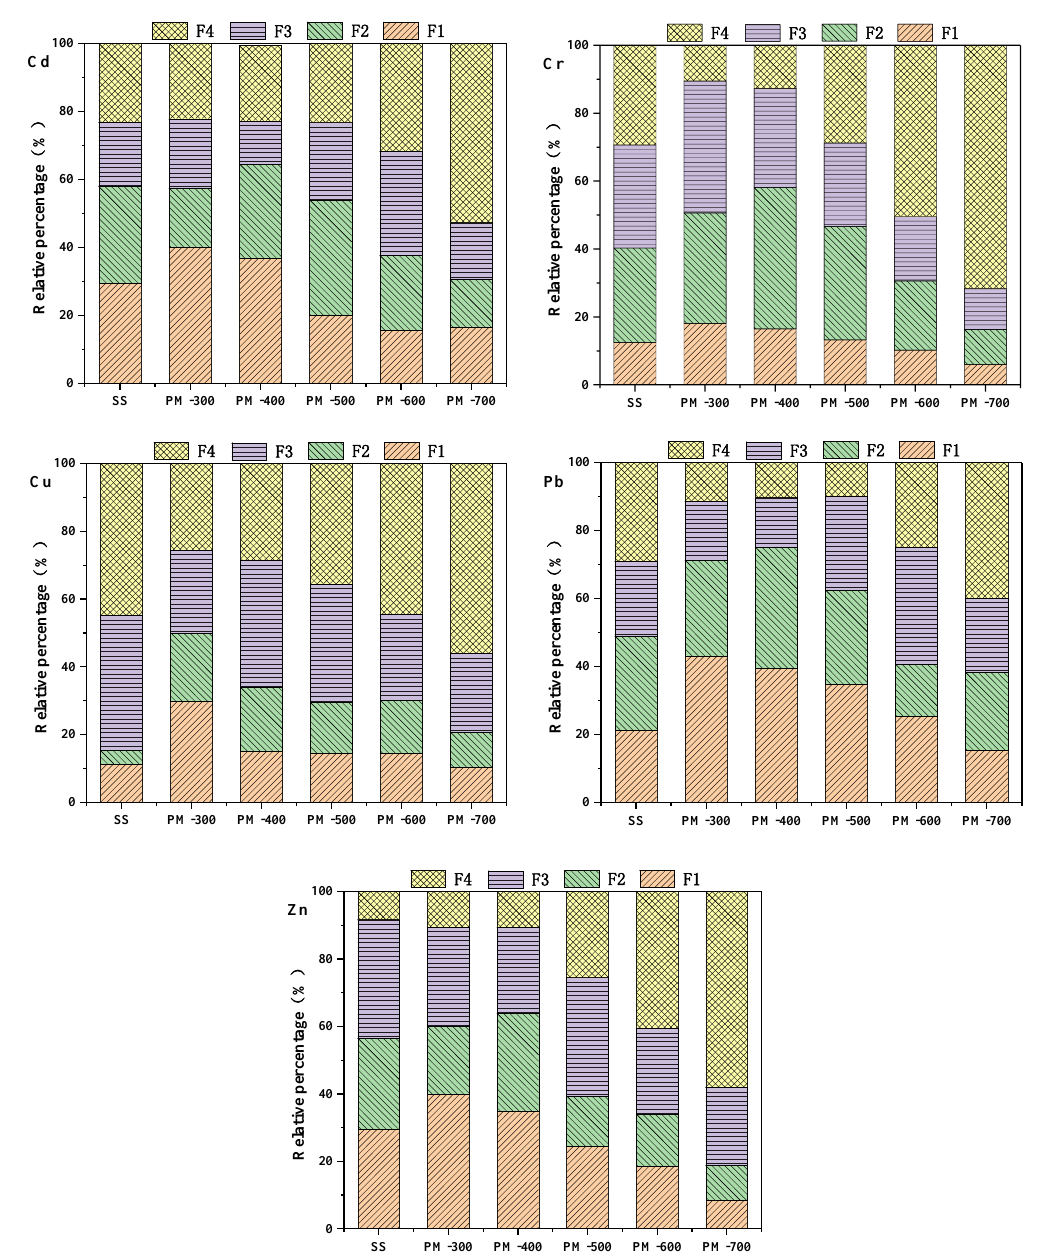
Figure 5. Chemical forms of heavy metals in sewage sludge and PM. F1, acid soluble and exchangeable states; F2, reducible fraction; F3, oxidizable fraction; F4, residual fraction.